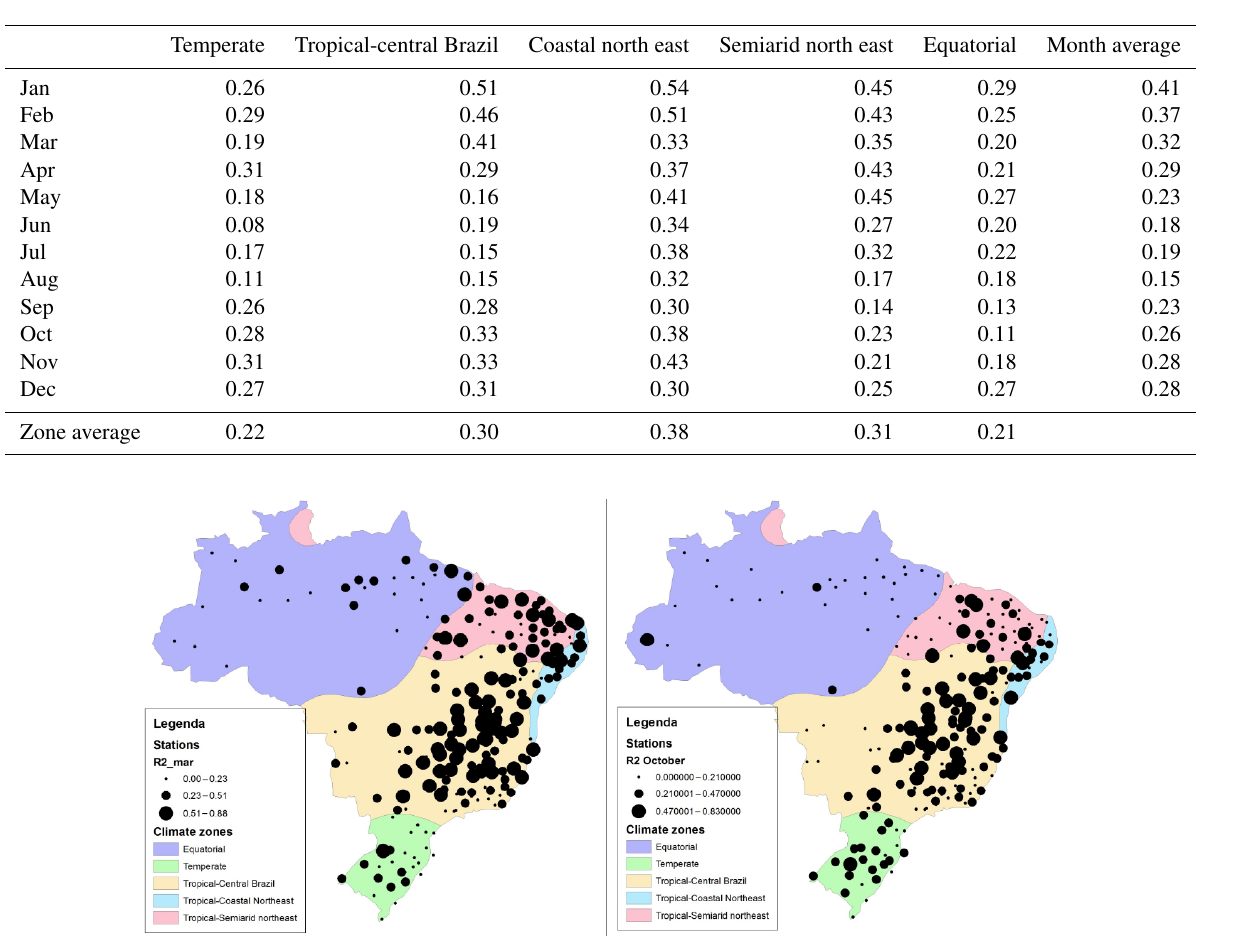
Table 8. Monthly averages of R 2 statistics for the regressions in each climate zone.